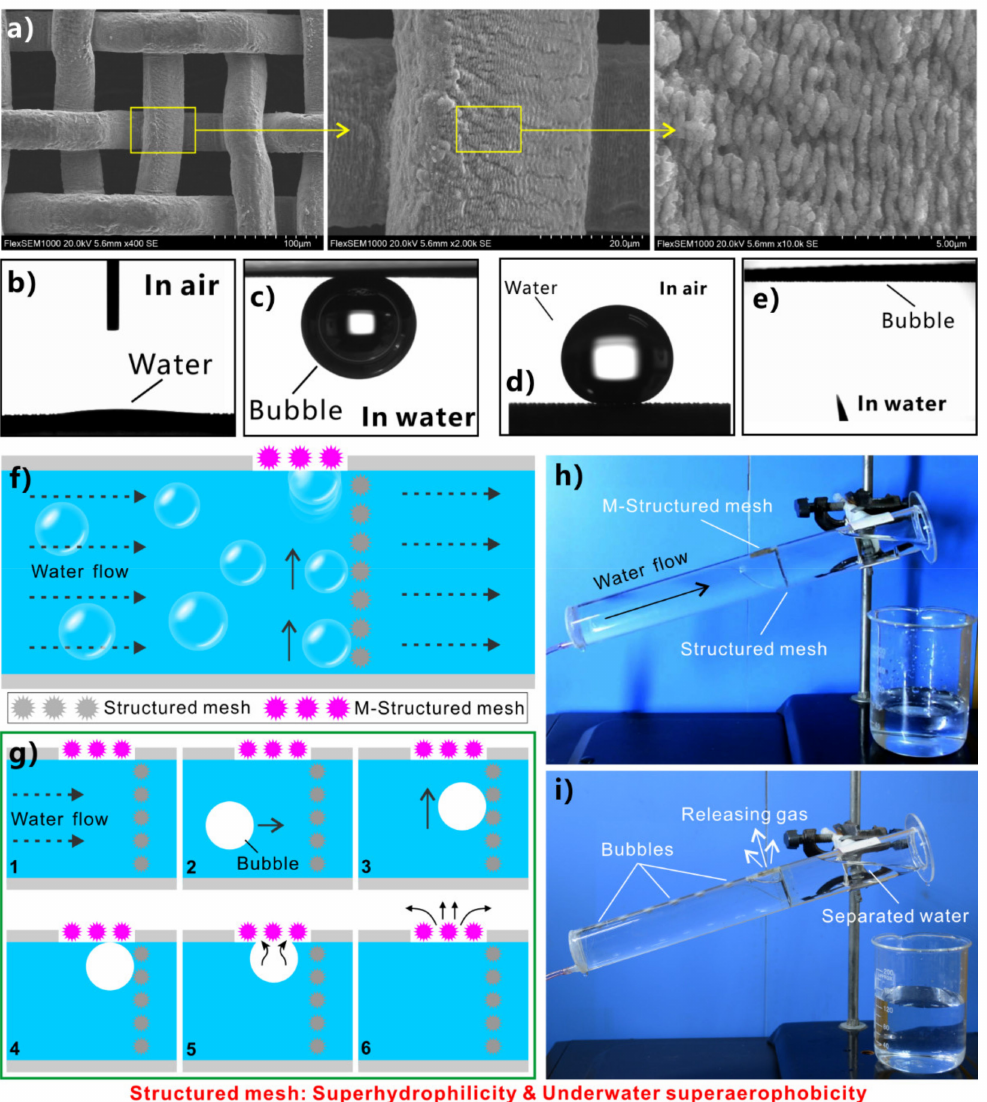
Figure 32. Removing bubbles from water flow by the combination of underwater superaerophobic and underwater superaerophilic meshes. ( a ) Surface microstructure of the laser-ablated stainless-steel mesh. ( b ) Water droplet (in the air) and ( c ) underwater bubble on the structured mesh. ( d ) Water droplet (in the air) and ( e ) underwater bubble on the M-structured mesh. ( f ) Schematic of a device composed of underwater superaerophobic and superaerophilic meshes for removing bubbles from the water in a pipeline. ( g ) The mechanism of the bubble-removing process. ( h , i ) Experimental result of removing bubbles in water flow by the artificial separation device: ( h ) before the appearance of bubbles and ( i ) after the appearance of bubbles. Reprinted with permission from ref. [348]. Copyright 2021, The Royal Society of